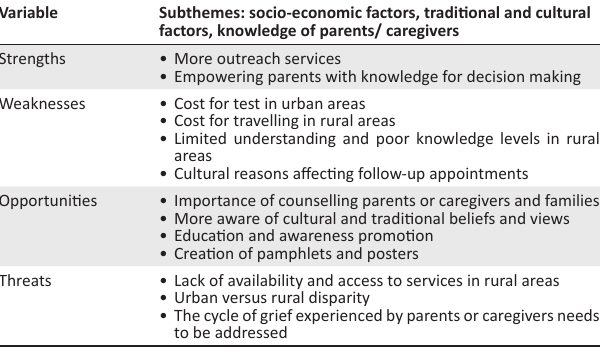
TABLE 5: Strengths, weaknesses, opportunities, and threats for theme 5: Engaging, understanding, and supporting caregivers or families.